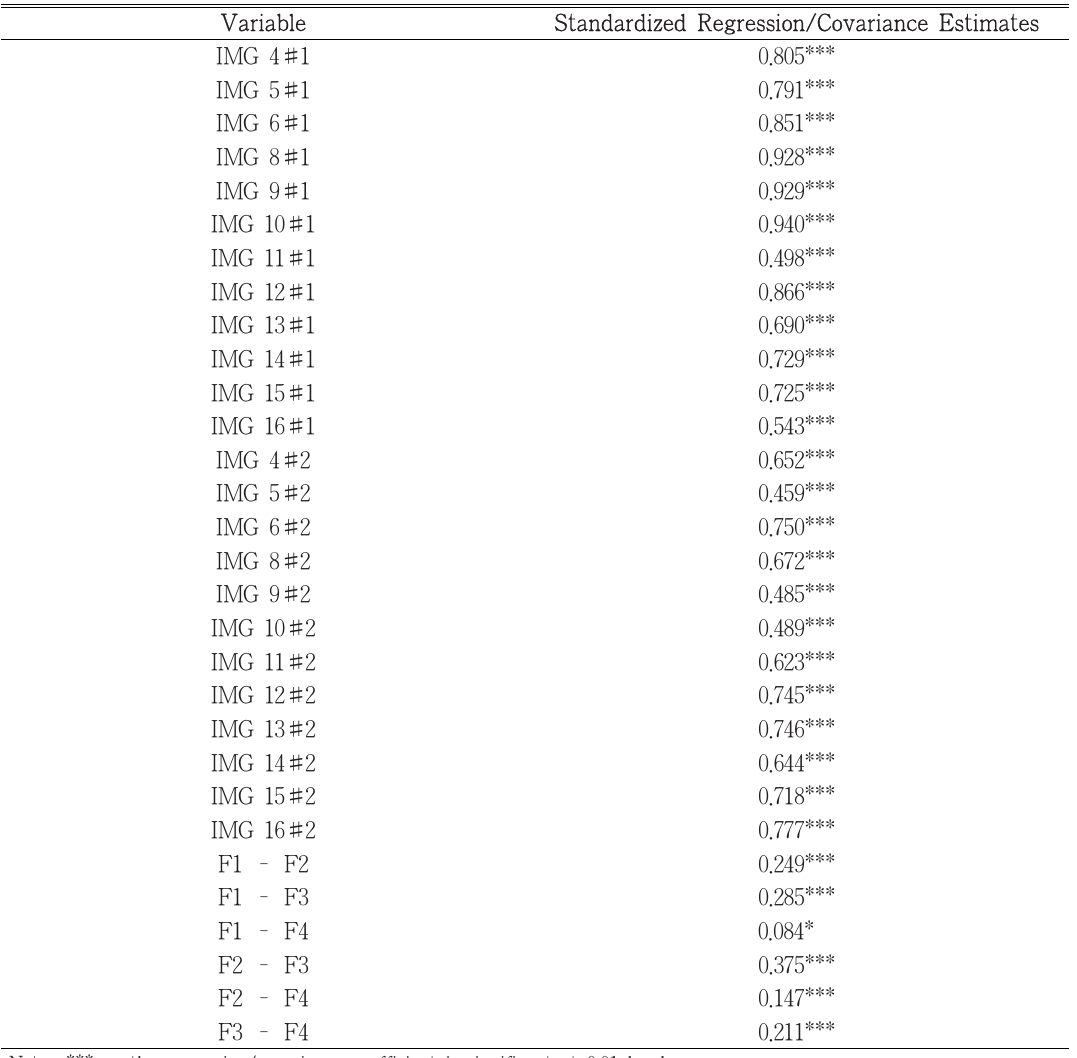
<Table 3> Results of Confirmatory Factor Analysis Without Product Type Control: Regression Coefficient and